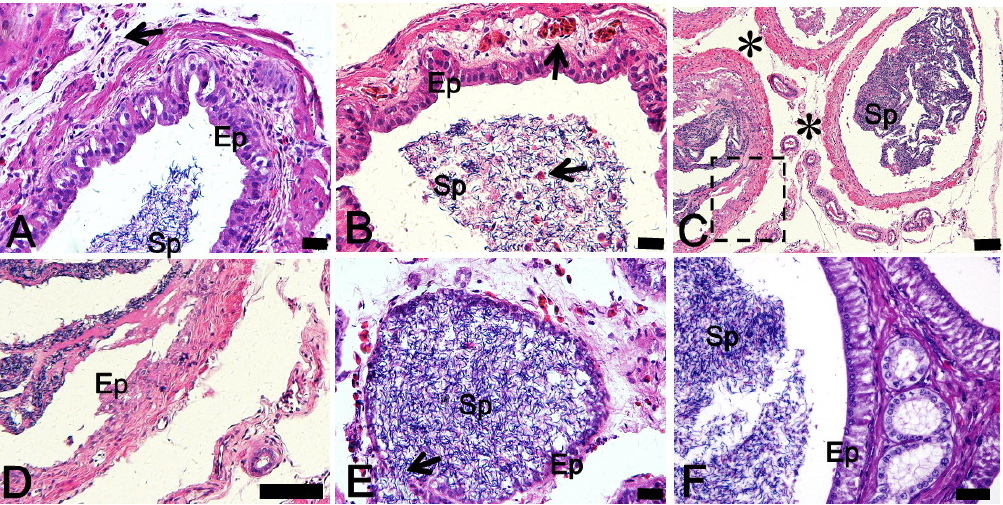
Figure 2. Photomicrograph of cauda epididymis in Chinese soft-shelled turtle with different treatment. Note: ( A ) Control; ( A ) CuNPs 5 mg kg −1 ; ( B ) CuNPs 50 mg kg −1 ; ( C ) CuSO 4 5 mg kg −1 ; ( D ) Higher magnification of the boxed area in ( C ); ( E ) CuSO 4 50 mg kg −1 ; ( F ) Control. The arrow in ( A ) shows connective tissue, the arrow in ( B ) shows blood cells, the asterisk in C also shows connective tissue, and the arrow in ( E ) shows sperm outflow. Ep, epithelium; Sp, Sperm. Scale bar: ( A , B , E ) = 20µm; ( C , D ) = 100 µm; ( F ) = 50 µm.